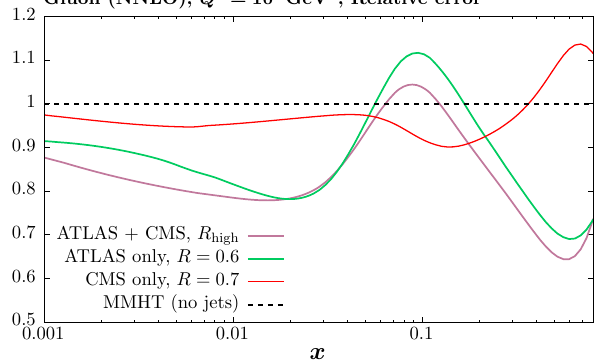
Fig. 14 The impact on the gluon PDF errors at NNLO of including the ATLAS [23] and CMS [24] 7 TeV jet data in the global fit. The ratio of the 68% C.L. errors to the baseline fit is shown. For the LHC case, R high and p jet ⊥ are